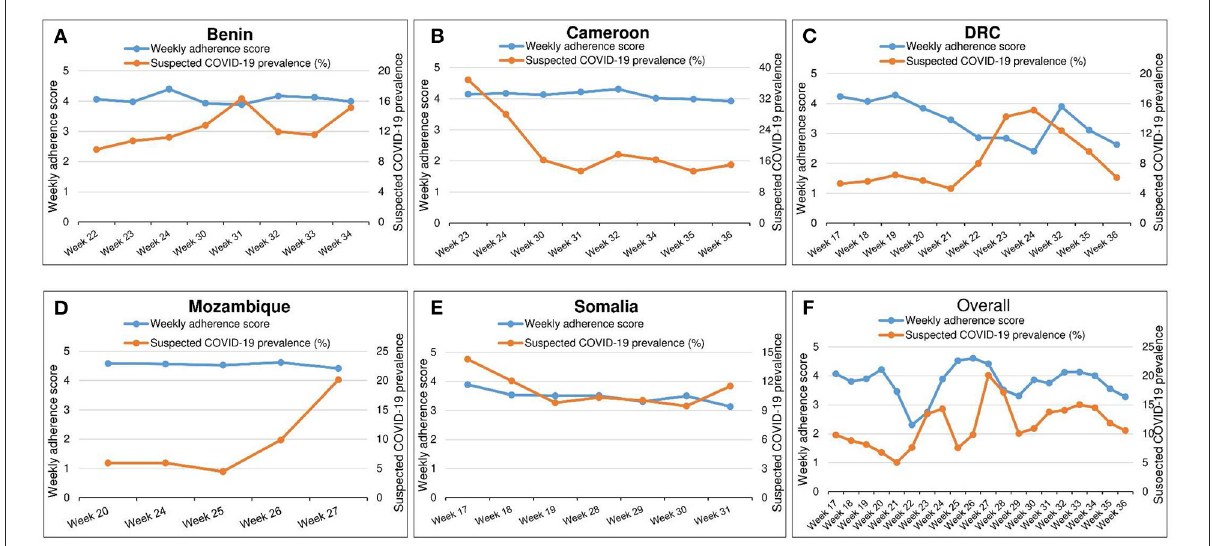
FIGURE2 (A–F) Evolution of weekly adherence scores (for week n ) and the rolling mean week-specific prevalence of suspected COVID-19 (for week n-1 and week n ). Uganda is not included in this analysis because data on flu-like symptoms was not collected during the Ugandan ICPCovid